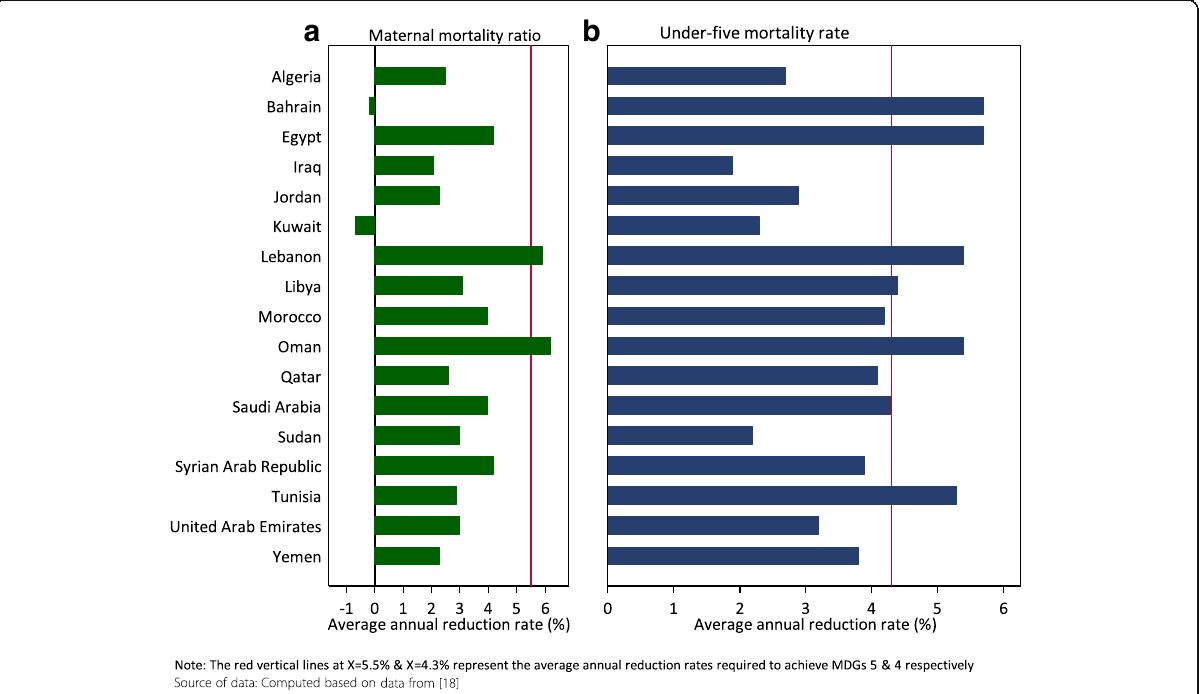
Fig. 1 Annual average rates of reduction – Maternal mortality ratio and under-five mortality rate by